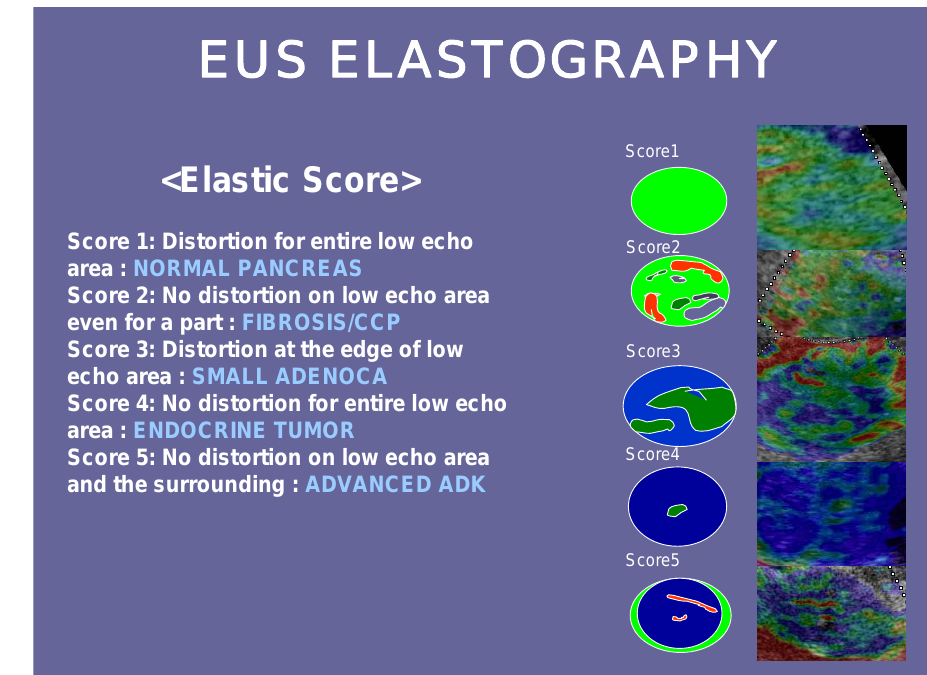
FIGURE 10 . Elastography score for pancreatic masses.